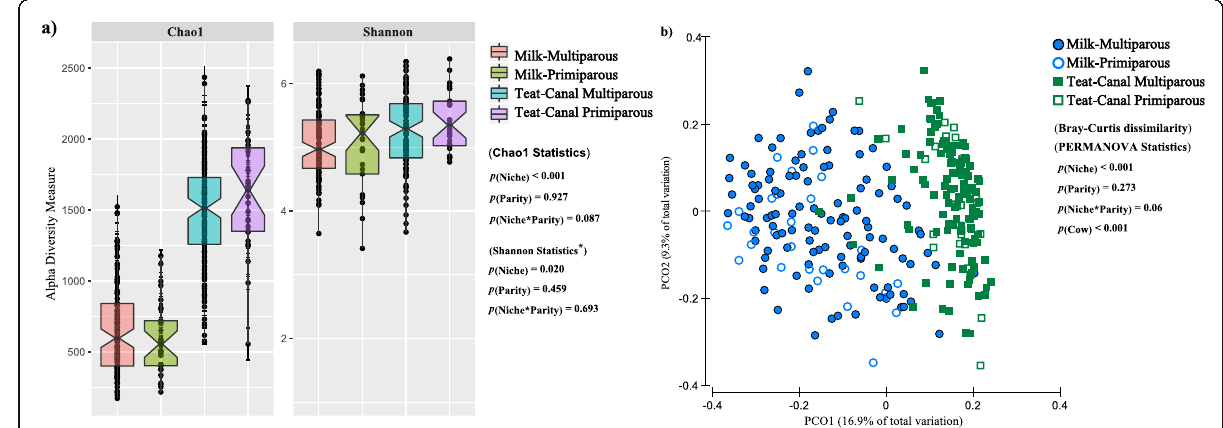
Fig. 1 Comparison of diversity metrics between teat canal and milk microbiota. a Chao1 index of species richness and Shannon ’ s index of diversity were compared between the teat canal and milk microbiota of primiparous and multiparous cows. The OTU table was normalized to an even depth of 4000 OTU per sample prior to calculation of diversity metrics. PROC MIXED of SAS 9.3 was used for ANOVA test and the effect of cow was included as random factor in all comparisons. “ * ” The original values for Shannon ’ s indices of diversity were subjected to Box-Cox power transformation to achieve normal distribution of the data prior to ANOVA. b Principal coordinate analysis (PCoA) was used for visualization of Bray-Curtis dissimilarities of the microbial communities. The OTU table was normalized using cumulative sum scaling (CSS) transformation. PERMANOVA was used to test for distinction of clustering patterns based on different niches of mammary gland and parity. The effect of cow was included as random factor in all comparison. For all tests p -values < 0.05 were considered as